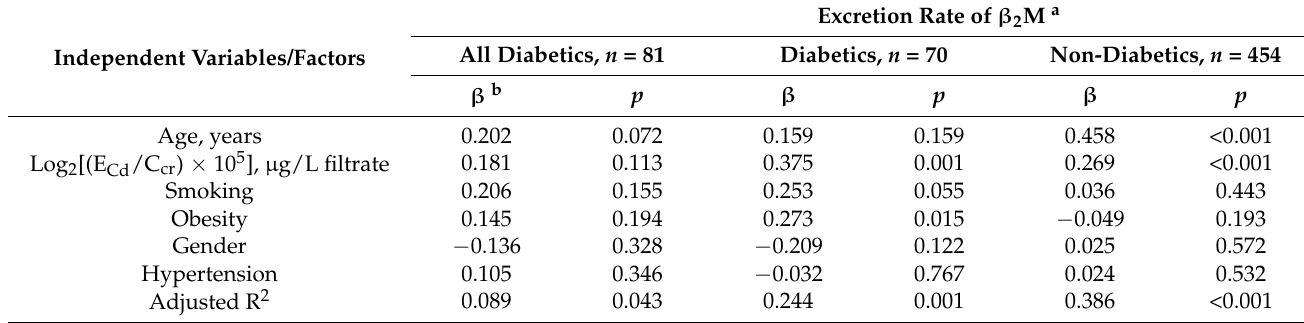
Table 3. Association of β 2 M excretion with cadmium excretion and other independent variables.